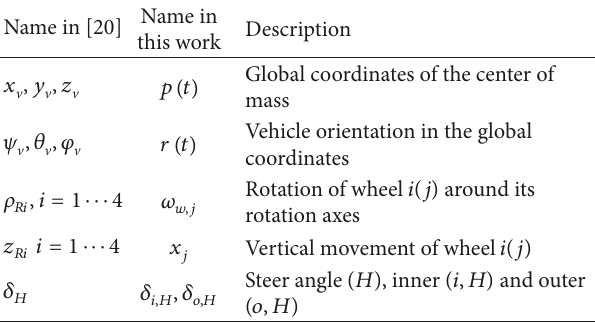
Table 2: Degrees of freedom of the dual track